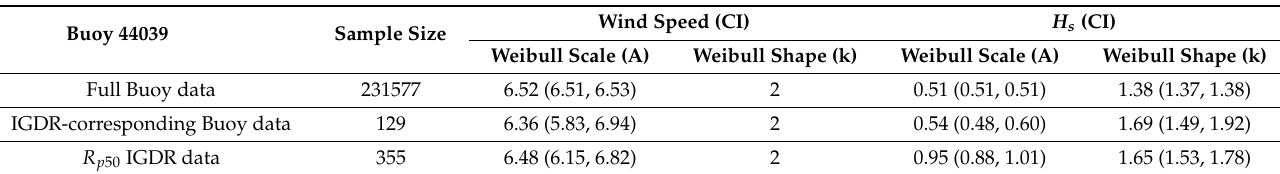
Table 7. Weibull shape and scale values with 95% confidence interval in parentheses for satellite and buoy data around Buoy 44039.